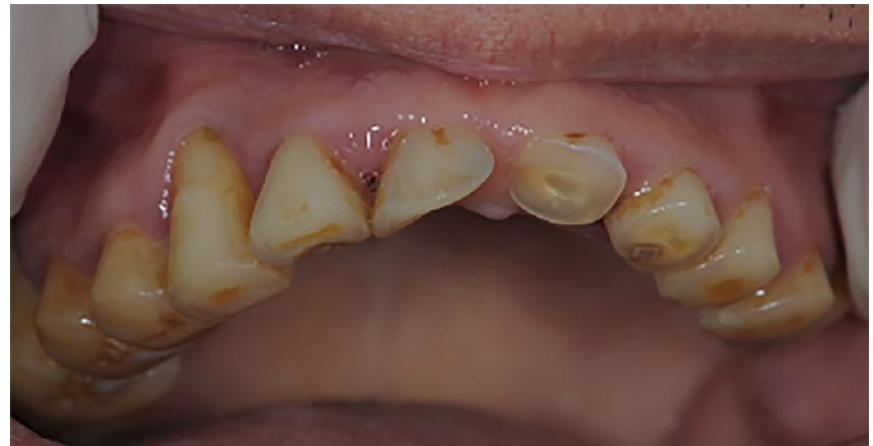
Figure 17. Case 5—Intraoral view of the maxillary arch of the patient.